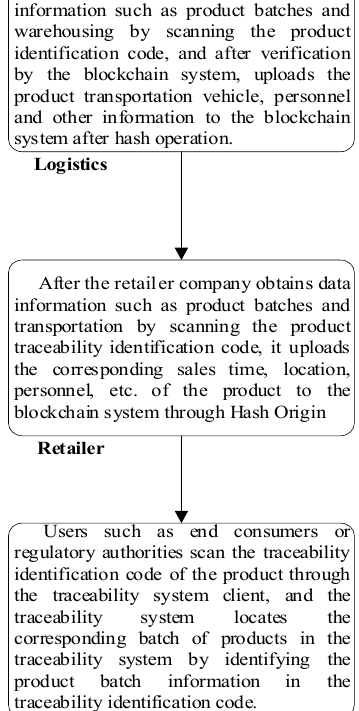
Figure 8. System-relevant data information flow chart.